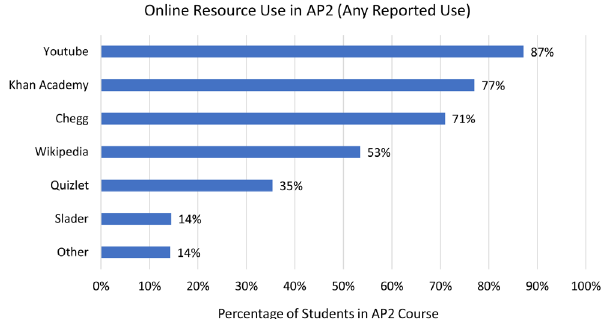
FIG. 8. Percentage of students in Analytical Physics 2 who reported any use of a given online resource ( N